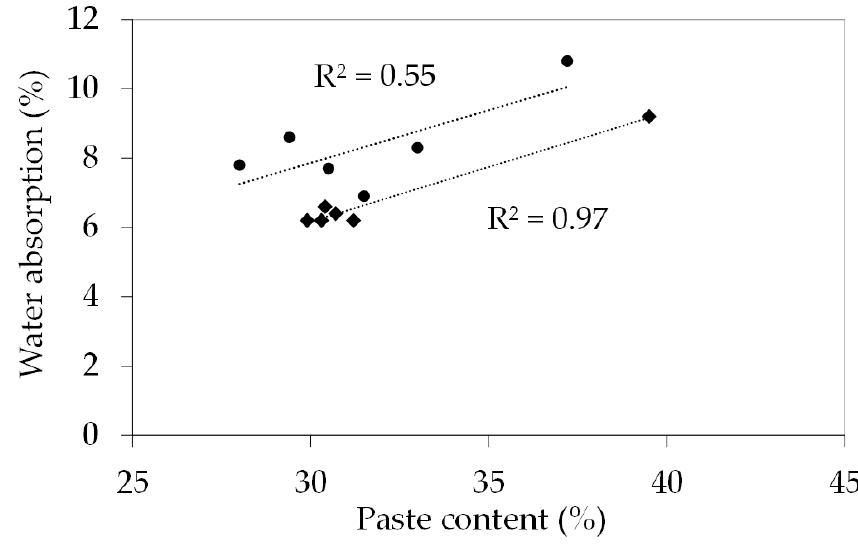
Figure 7. Link between paste content and WA for RG.